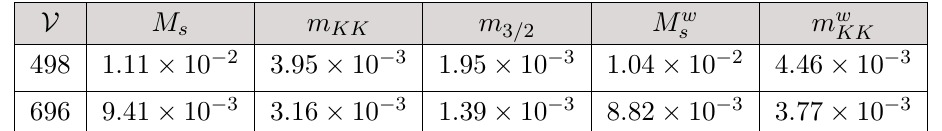
, revealing an unstable 3